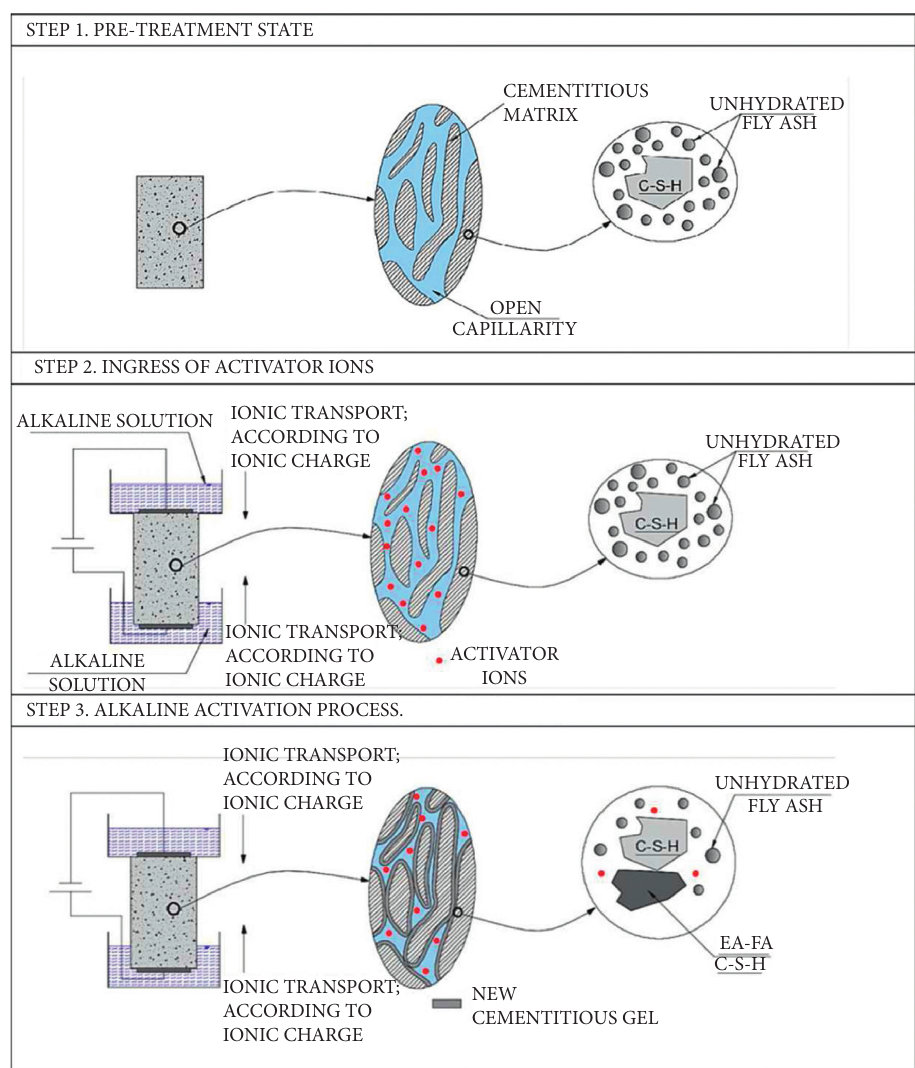
Figure 17: Preliminary conceptual model of the electrochemical activation process, reproduced from [127], with permission from Elsevier,